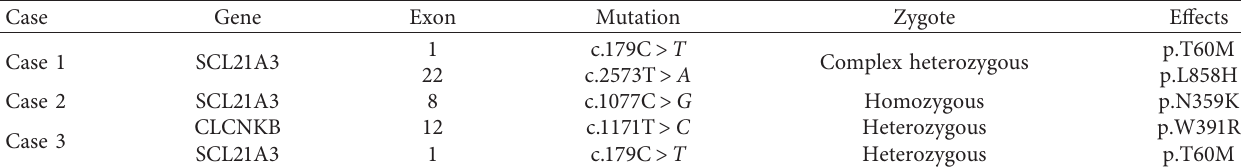
Table 2: Gene mutations in the 3